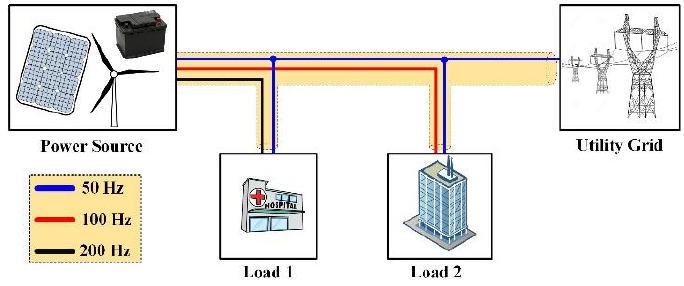
Figure 1. The conceptual diagram of the proposed multi-channel-based power system.